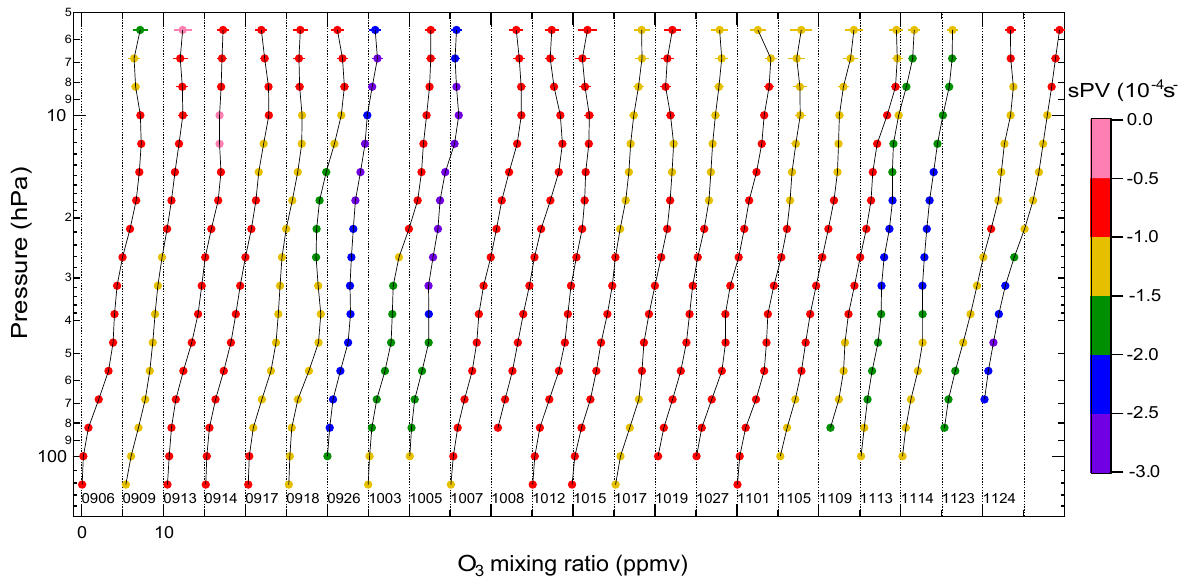
Figure 3. Time series of DIAL O 3 profiles at the OAPA site. Each profile is shifted 5ppmv. Data are color coded based on sPV values. Observation dates in 2009 are shown as MMDD (e.g., 0906 is 6 September 2009).